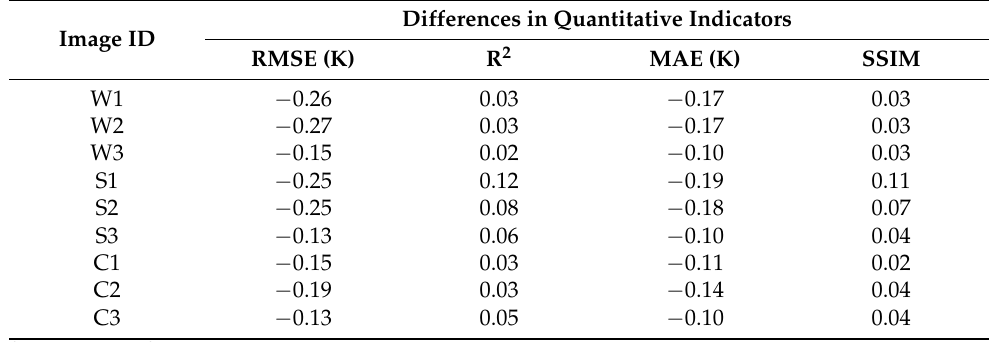
Figure 9. Error probability density plots of downscaling results for different methods. The labels ( a – i ) represent the image IDs of W1, W2, W3, S1, S2, S3, C1, C2, and C3. Table 4. Differences in quantitative indicators between SRFD and SRFD-R downscaling